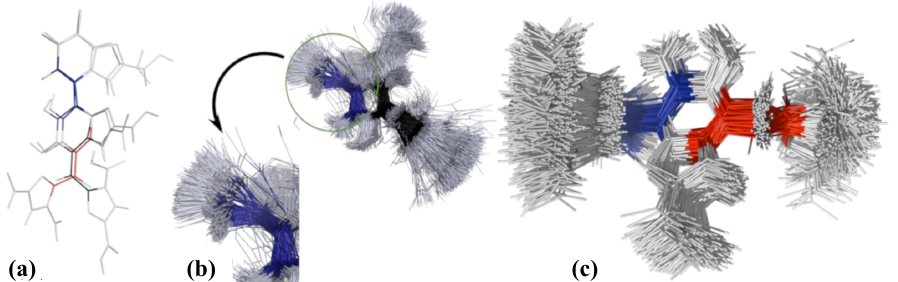
Figure 9. ( a ) Snapshots of two single-aligned charged and uncharged DHICA-eumelanins: ( b , c ) 100 superimposed structures over the last 100ns from the systems of four uncharged ( b ) and four charged ( c ) DHICA-eumelanins, respectively. The angle C6-C7-C4 (cid:48) -C5 (cid:48) is shown in blue, C8 (cid:48) - C7 (cid:48) -C-C3 (cid:48)(cid:48) for the charged DHICA-eumelanin is in red, and for uncharged is in